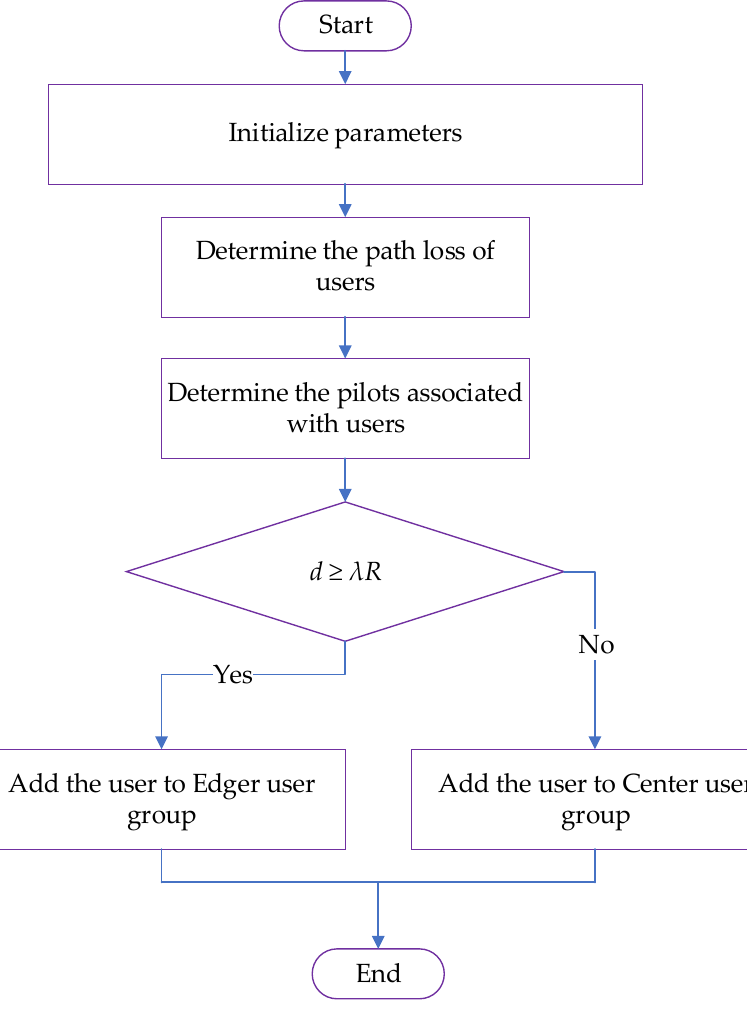
Figure 3. Proposed IPLUG algorithm flowchart.